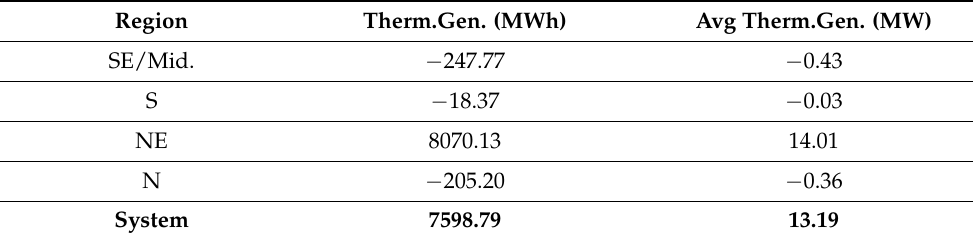
Table 4. Thermal generation differences between DR case and base case.